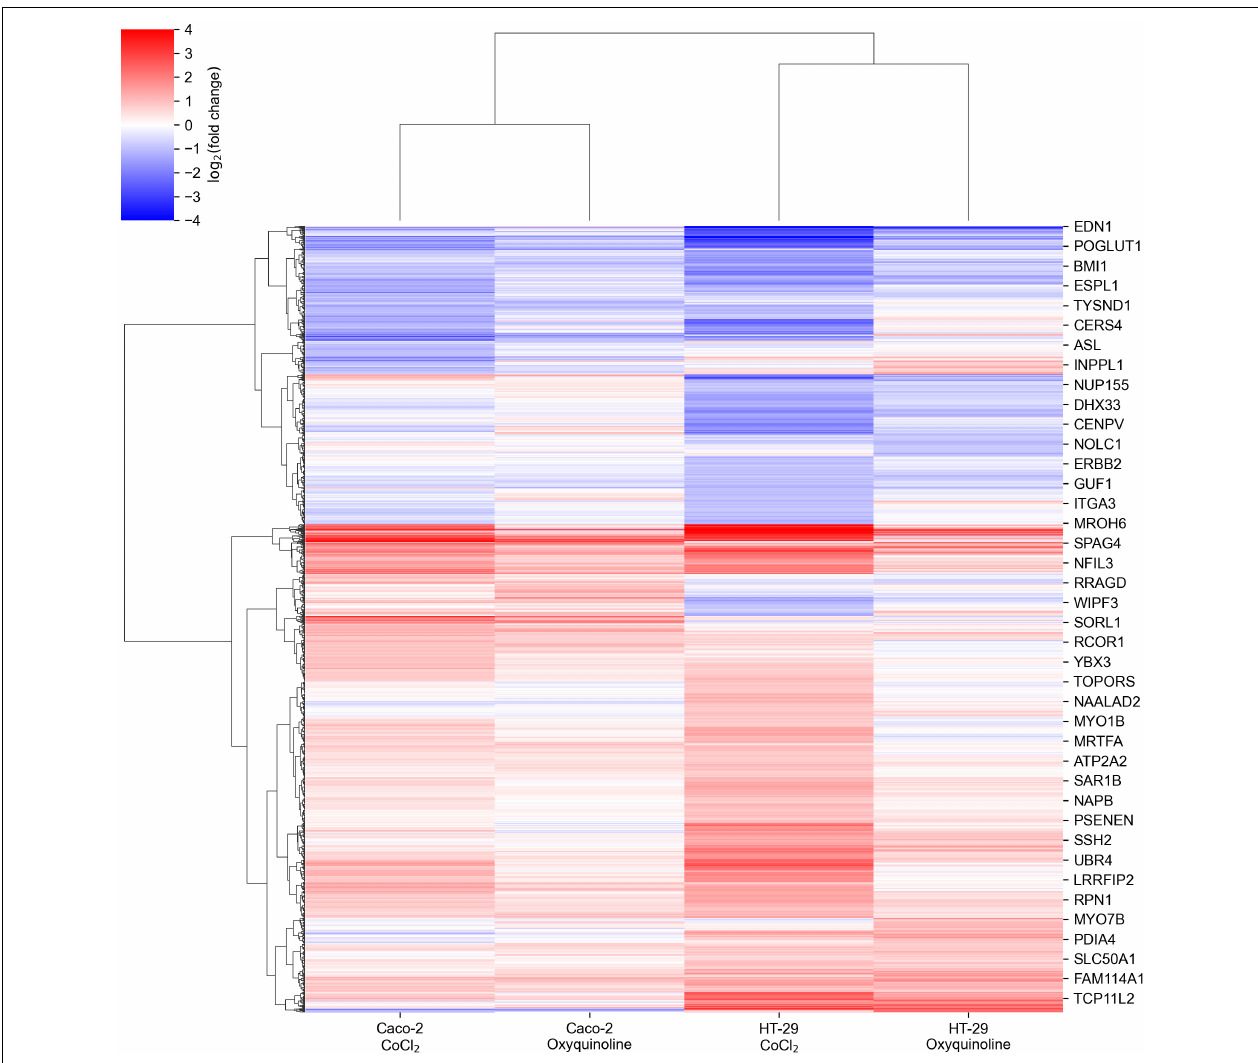
FIGURE 1 | Changes in mRNA expression levels of colorectal cell lines exposed to chemically simulated hypoxia. A gene is included in the plot in case if it is differentially expressed in at least one out of four experimental conditions.